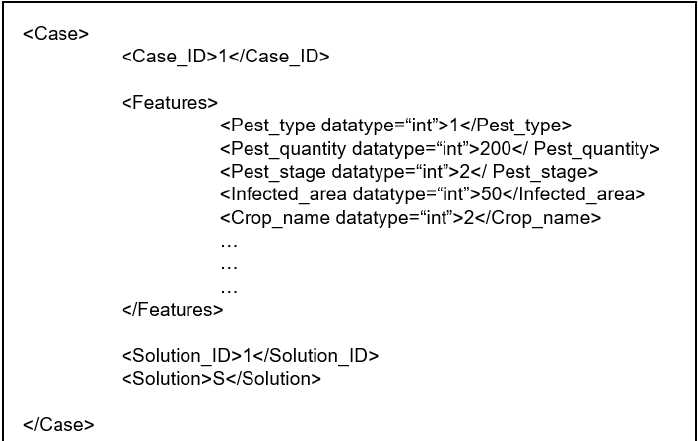
Figure 6. An example of the pair representation in an agricultural decision support system (ADSS).